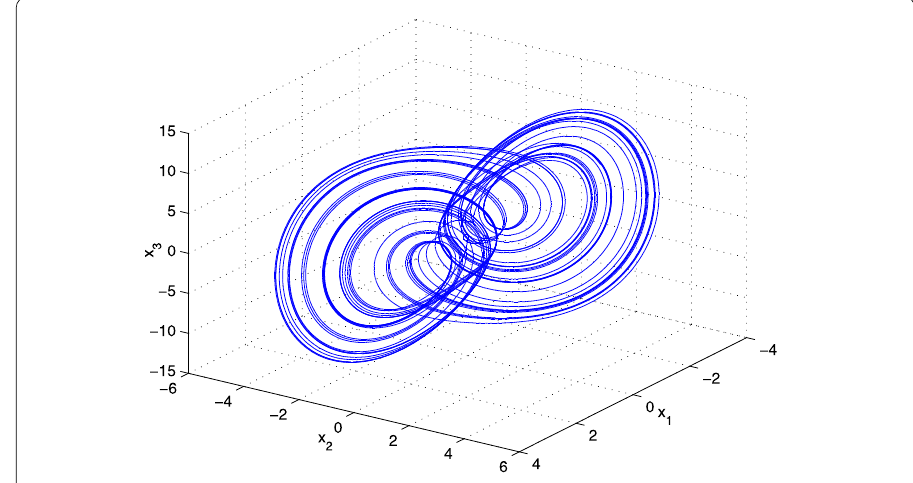
Figure 4 Chaotic behavior of fractional-order chaotic Arneodo’s system (4.6) with α = 0.97.